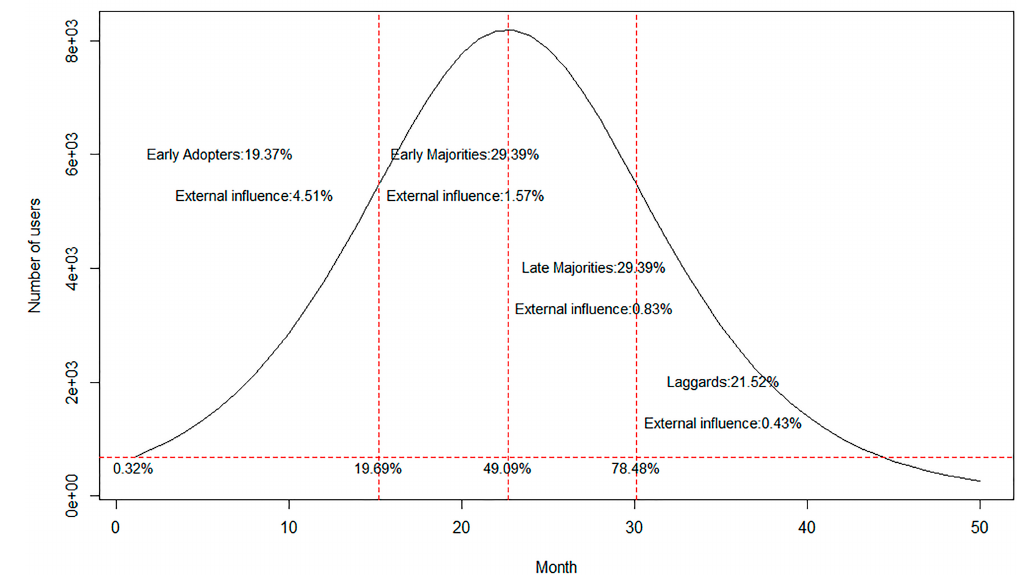
Figure 7. User segmentation.